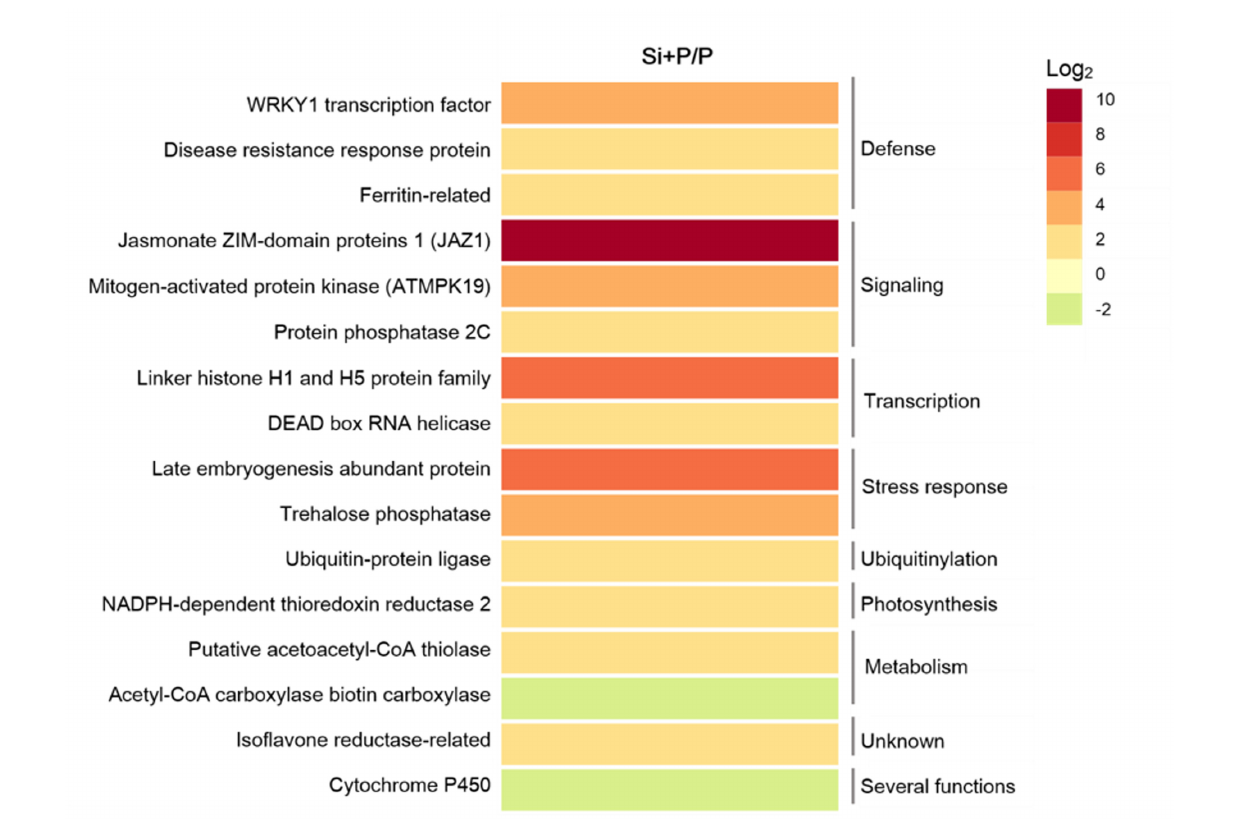
FIGURE 3 | Significantly regulated genes in response to silicon in tomato plants after infected with Ralstonia solanacearum for 72 h (Ghareeb et al., 2011). The heatmap represents the ratio of genes expression between plants with silicon and inoculated with R. solanacearum (Si + P) and plants without silicon and inoculated with R. solanacearum